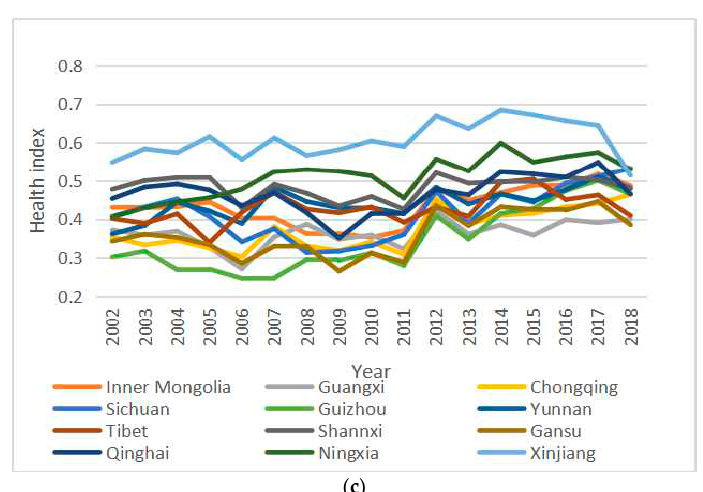
Figure 2. The change trend of Chinese citizens’ health indexes. ( a ) The change trend of citizens’ health indexes (the eastern region); ( b ) The change trend of citizens’ health indexes (the central region); ( c ) The change trend of citizens’ health indexes (the western region), (from the eastern, central, and western regions).